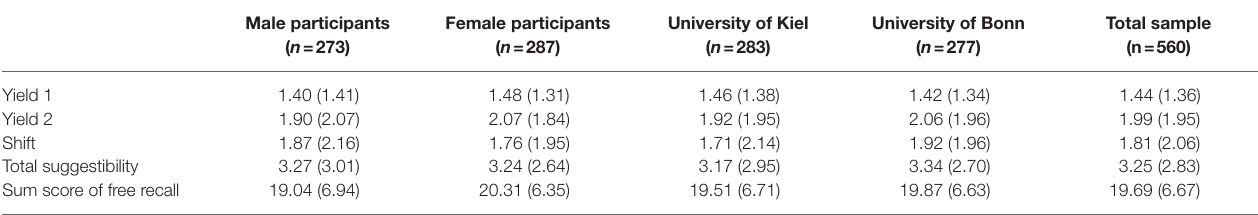
scales for single cases.